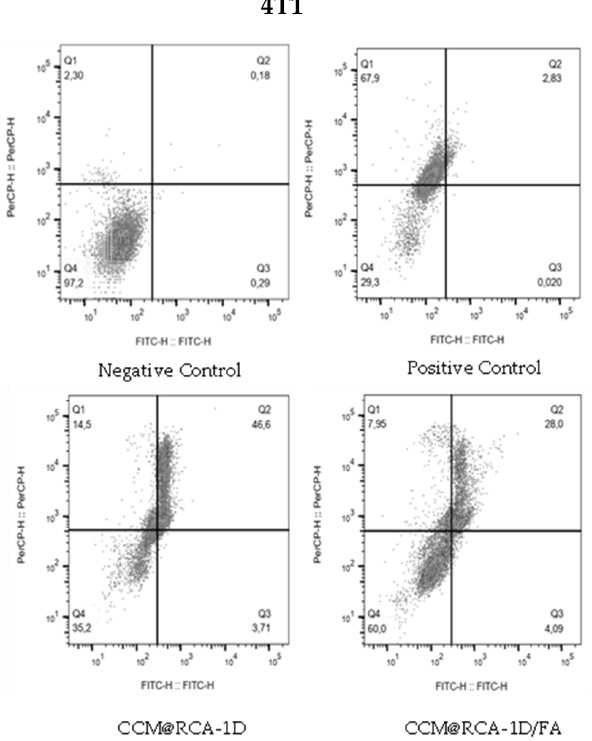
Figure 15. Graph representing the cell death mechanism of compounds CCM@RCA-1D and CCM@RCA-1D/FA in cell line 4T1 and MCF-7.